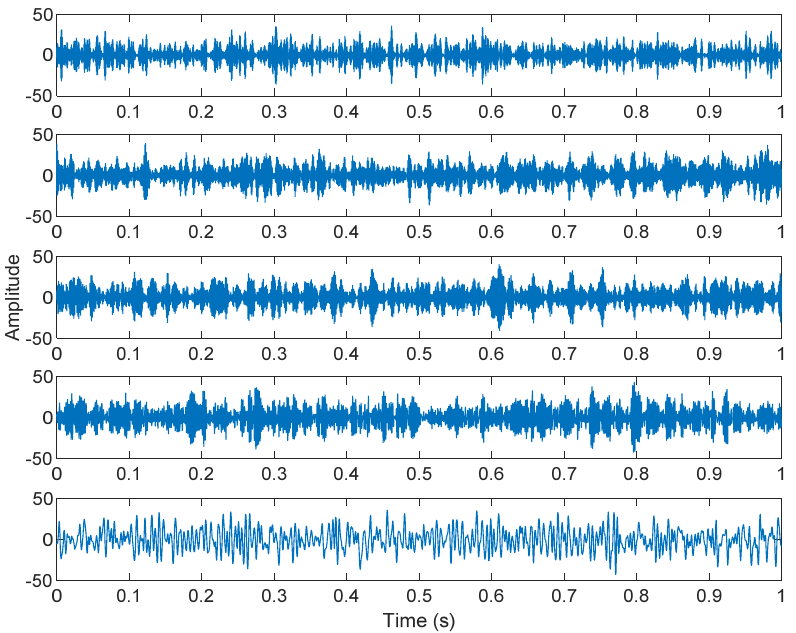
Figure 13. The results of the VMD component obtained from the numerical simulation of the sensor.